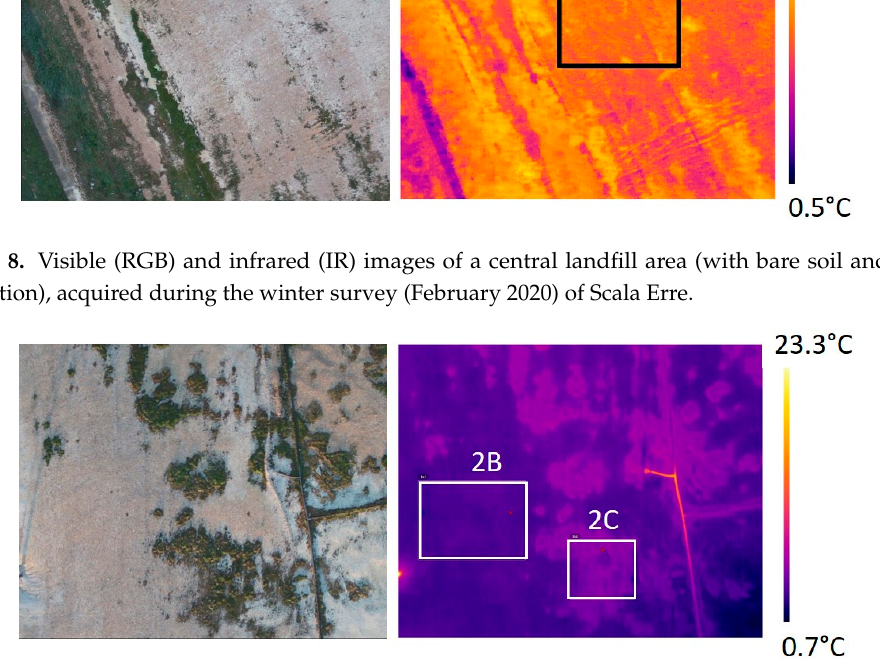
Figure 9. Visible (RGB) and infrared (IR) images of a landfill area with bare soil, low vegetation, and pipes and wells, acquired during the winter survey (February 2020) of Scala Erre.